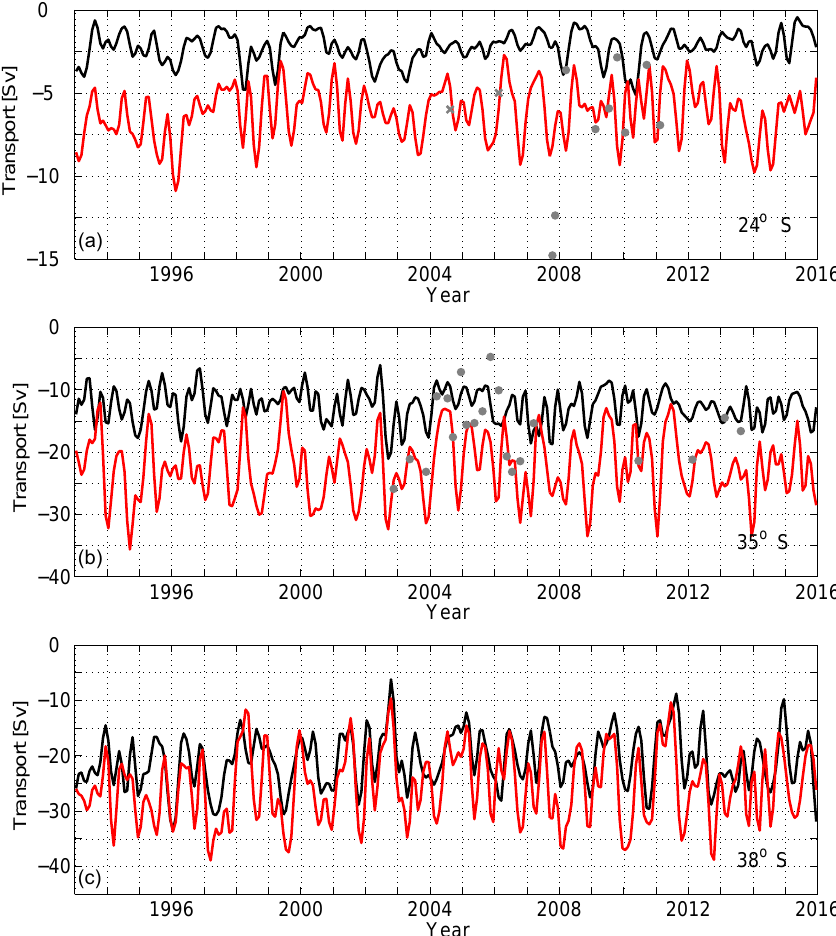
Figure 5. Time series of the meridional transports in the Brazil Current at 24, 35, and 38 ◦ S from Argo&SSH (black) and HYCOM (red). The depth range is 0 to 400m at 24 ◦ S and 0 to 800m at the other latitudes. The time series were smoothed with a second-order Butterworth filter (2 month low pass). Gray dots are based on transport estimates by Garzoli et al. (2013). Gray crosses indicate estimates from other studies (see Fig. 1 for